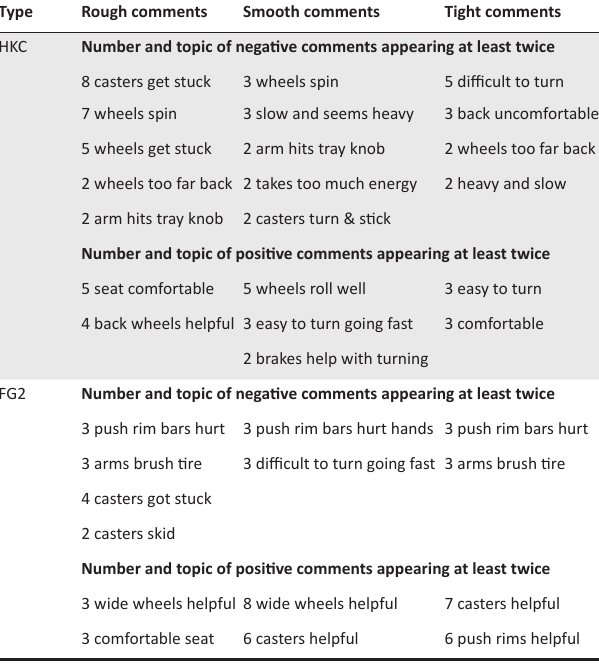
FIGURE 3: The analysis of variance interaction plots for the comparison between Free Wheelchair Mission Generation 2 and Hope Haven KidChair wheelchairs on rough, smooth and tight spaces rolling TABLE 2: Coded and counted comments from the comparison between Free Wheelchair Mission Generation 2 and Hope Haven KidChair wheelchairs on rough, smooth and tight rolling environments ( n = 30).